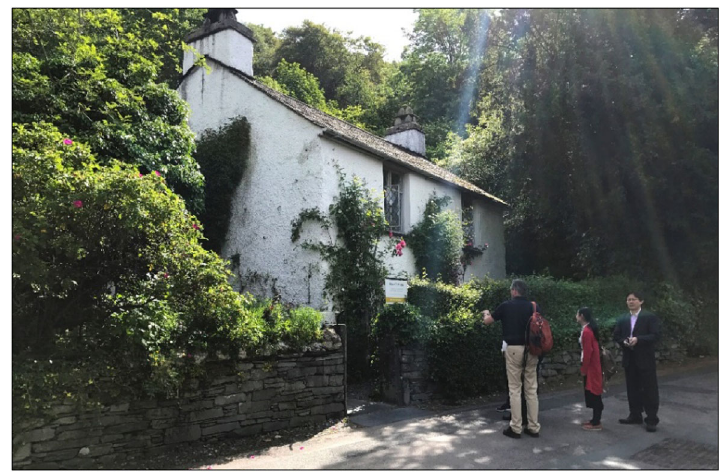
Fig. 14 Wordsworth ’ s home, Dove Cottage, English Lake